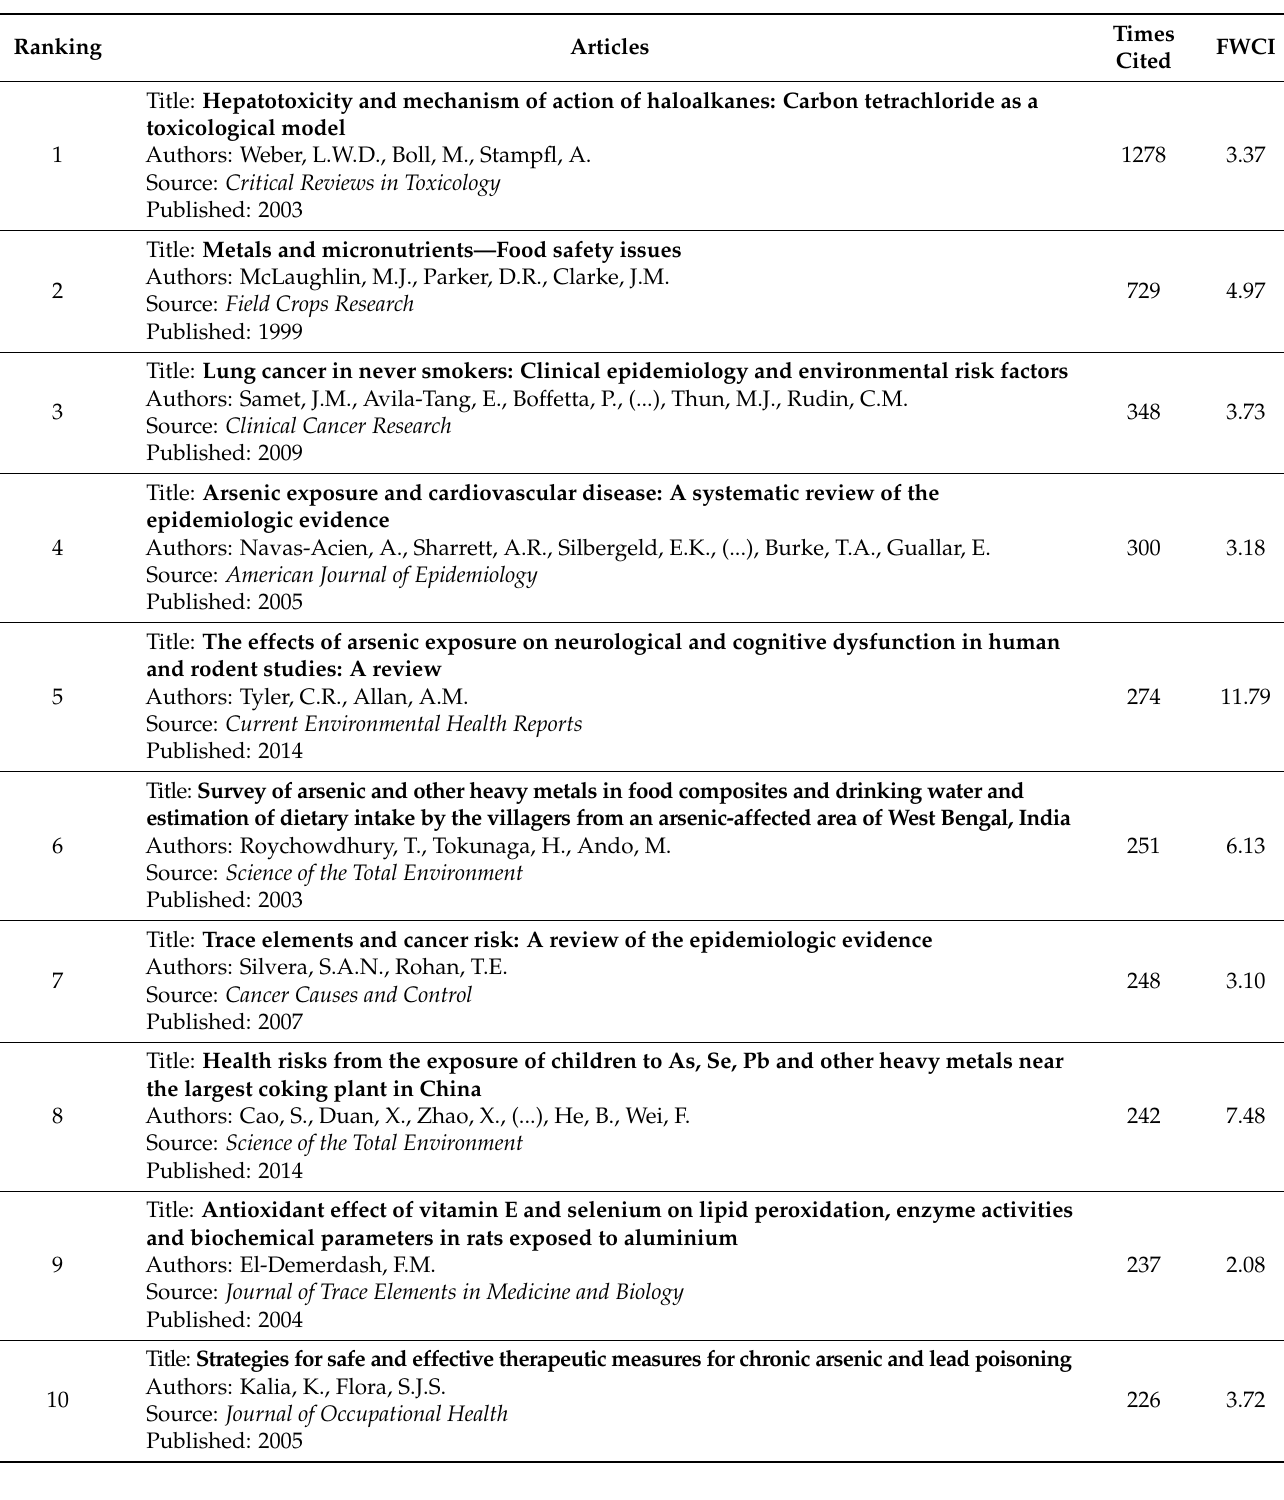
Table 6. The top 10 most cited